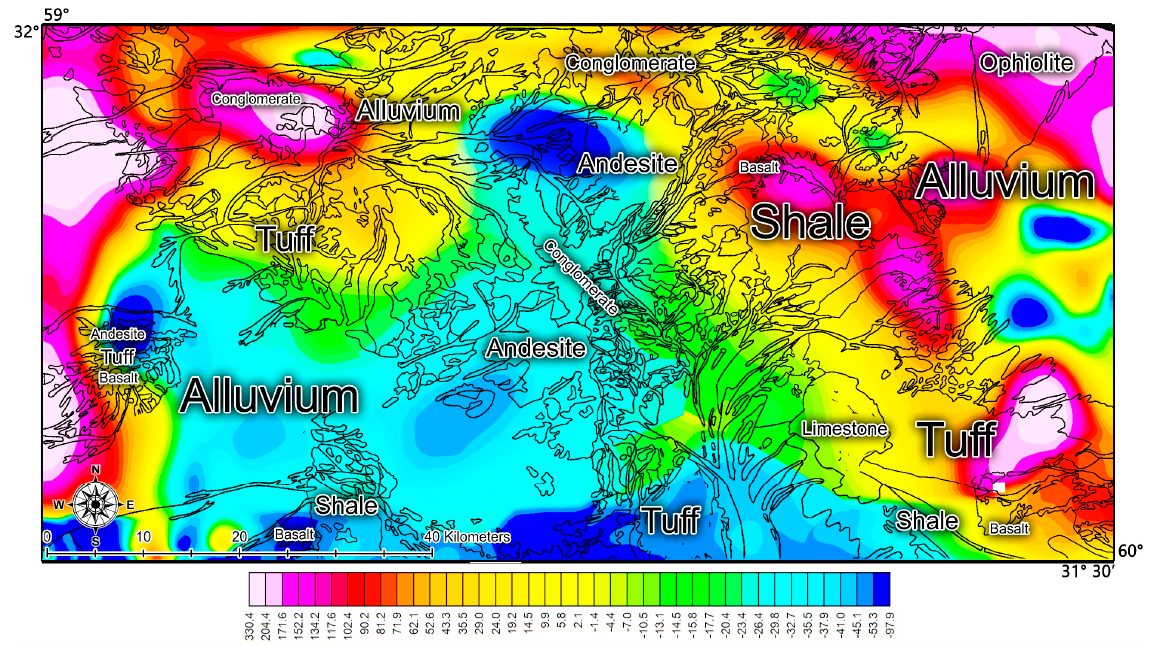
Figure 8. The residual map of airborne magnetometric data analyzed by gradient tensor method.